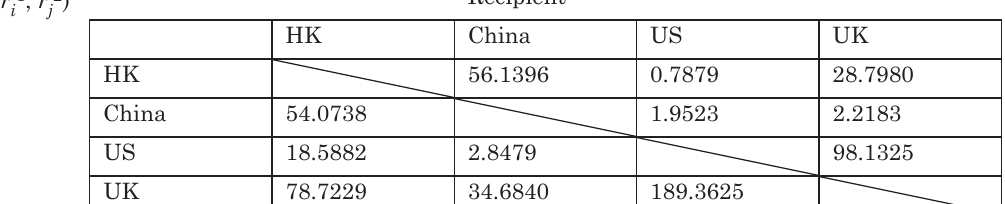
table 3. the results of the coskewness test on